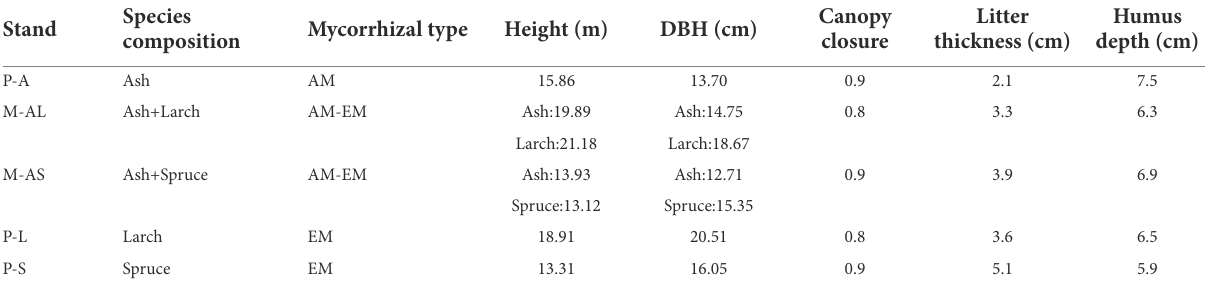
TABLE 1 The features of AM, EM tree species monoculture and mixture plantation stands in Maoershan Experiment Station, Northeast China. Species Stand